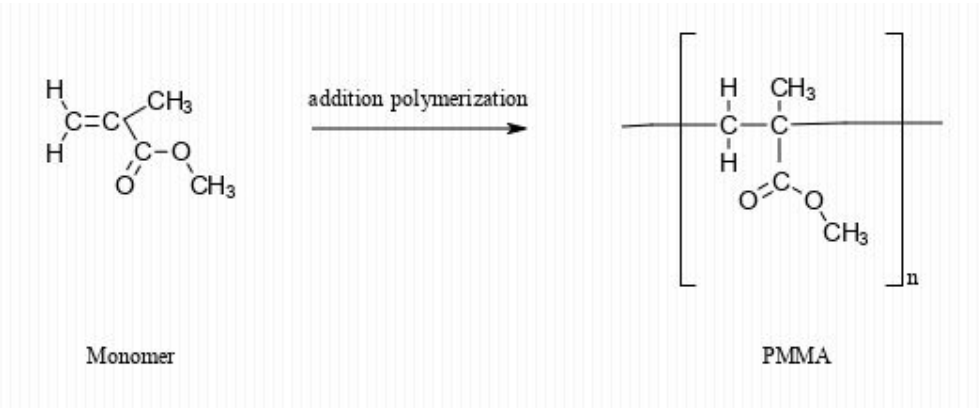
Figure 2. MMA polymerization is used to obtain poly(methyl methacrylate) (PMMA).